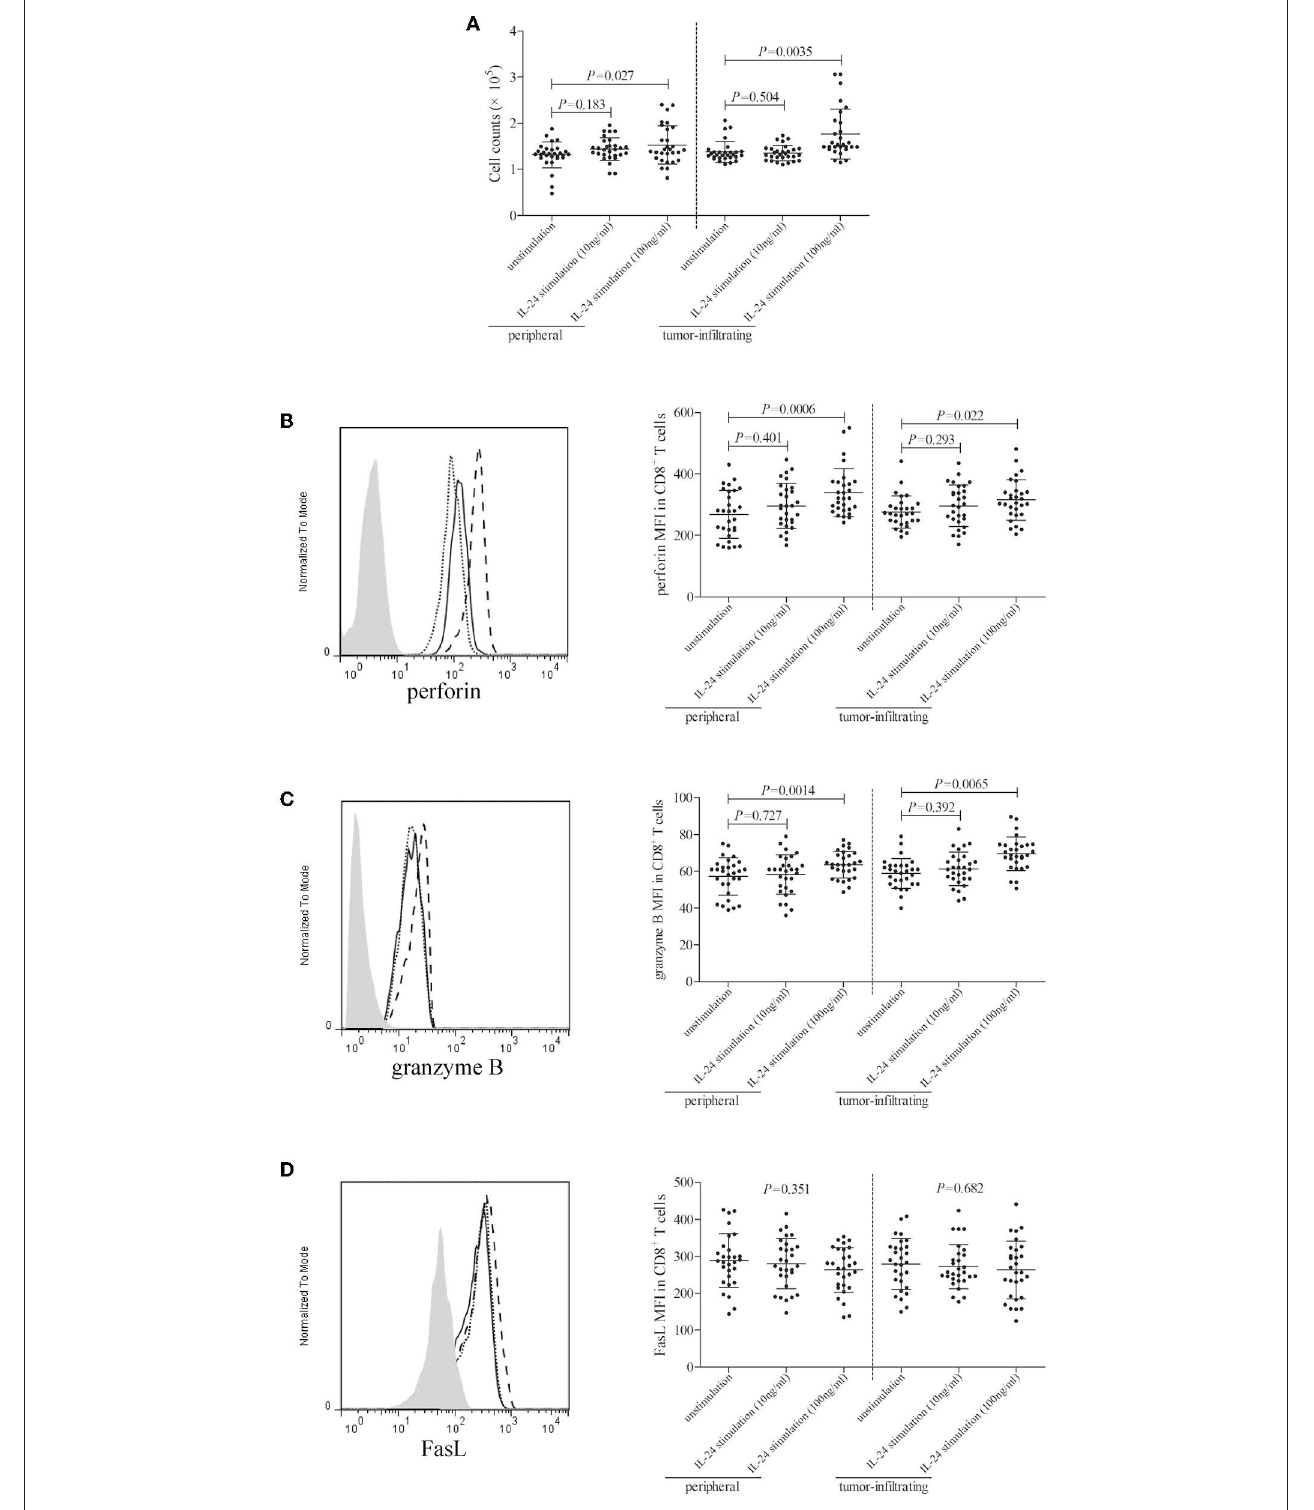
FIGURE 5 | Influence of recombinant IL-24 stimulation on peripheral and tumor-infiltrating CD8 + T cell activity in colorectal adenocarcinoma. 10 5 of purified CD8 + T cells from colorectal adenocarcinoma patients ( n = 29) were stimulated with low concentration (10ng/ml) or high concentration (100ng/ml) of recombinant